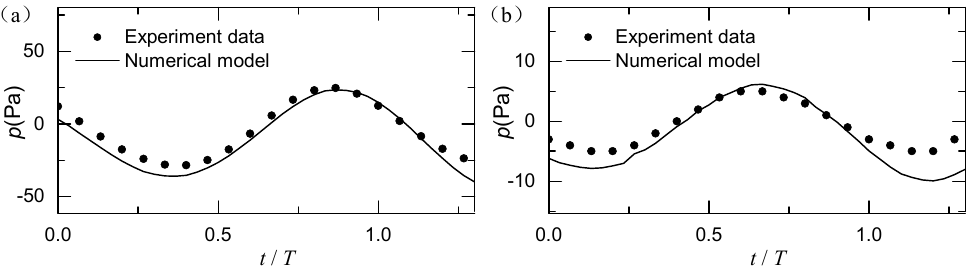
Figure 5. Comparison of the simulated and measured excess pore pressure recorded in test 5, ( a ) PPT1 and ( b ) PPT5.